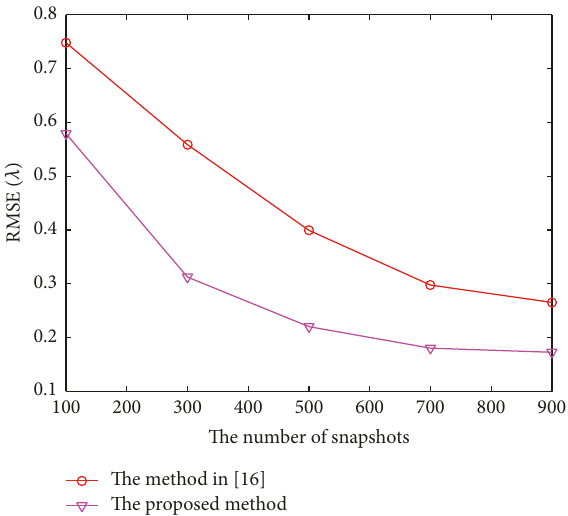
Figure 9: Angular resolution ability as a function of the number of